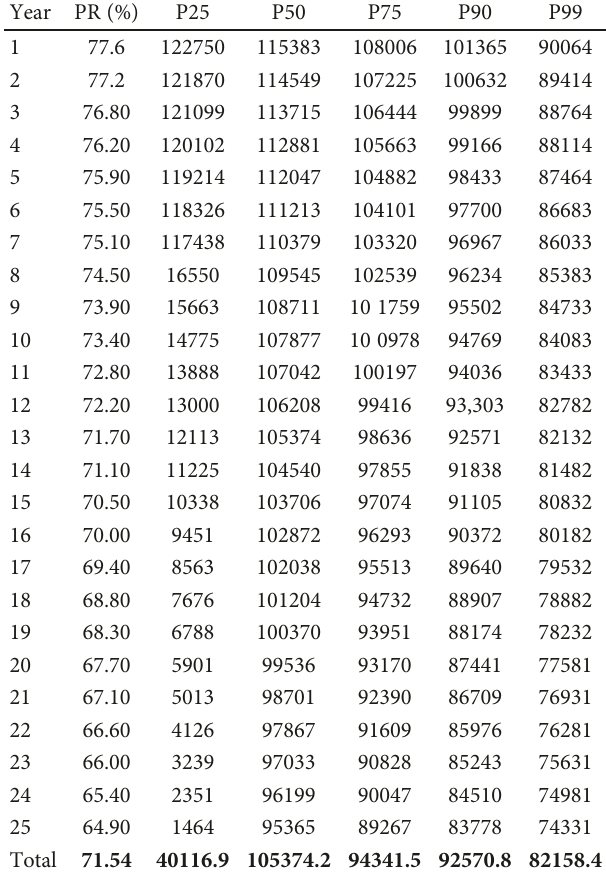
Table 12: Performance ratio and net energy output (MWh/year) for one-year